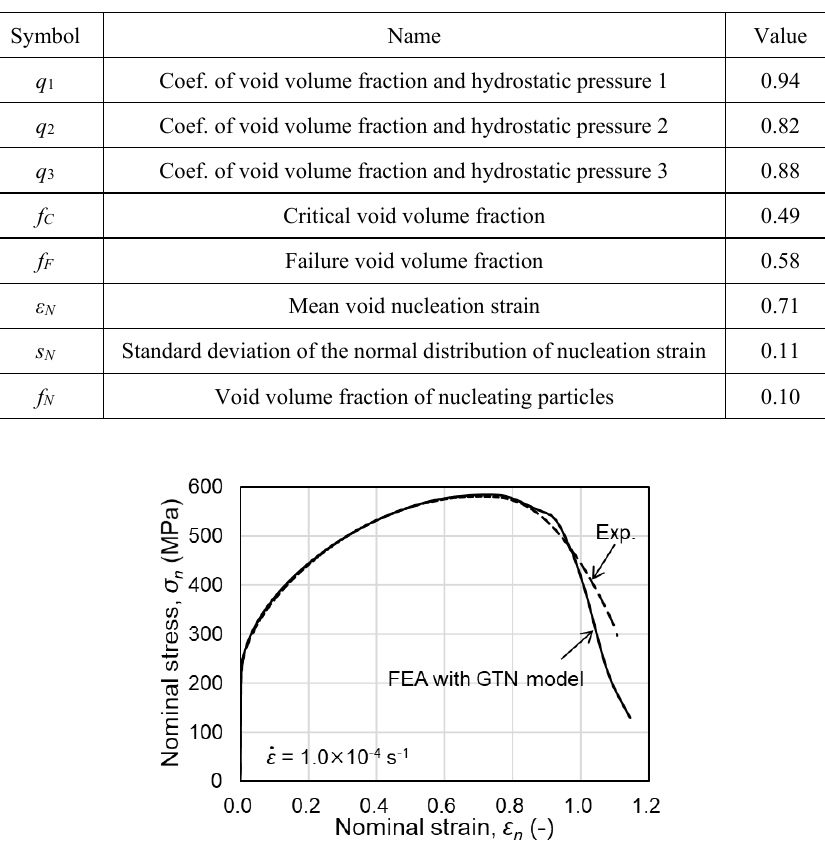
Table 2. Identified GTN parameters using quasi-static speed tensile test result